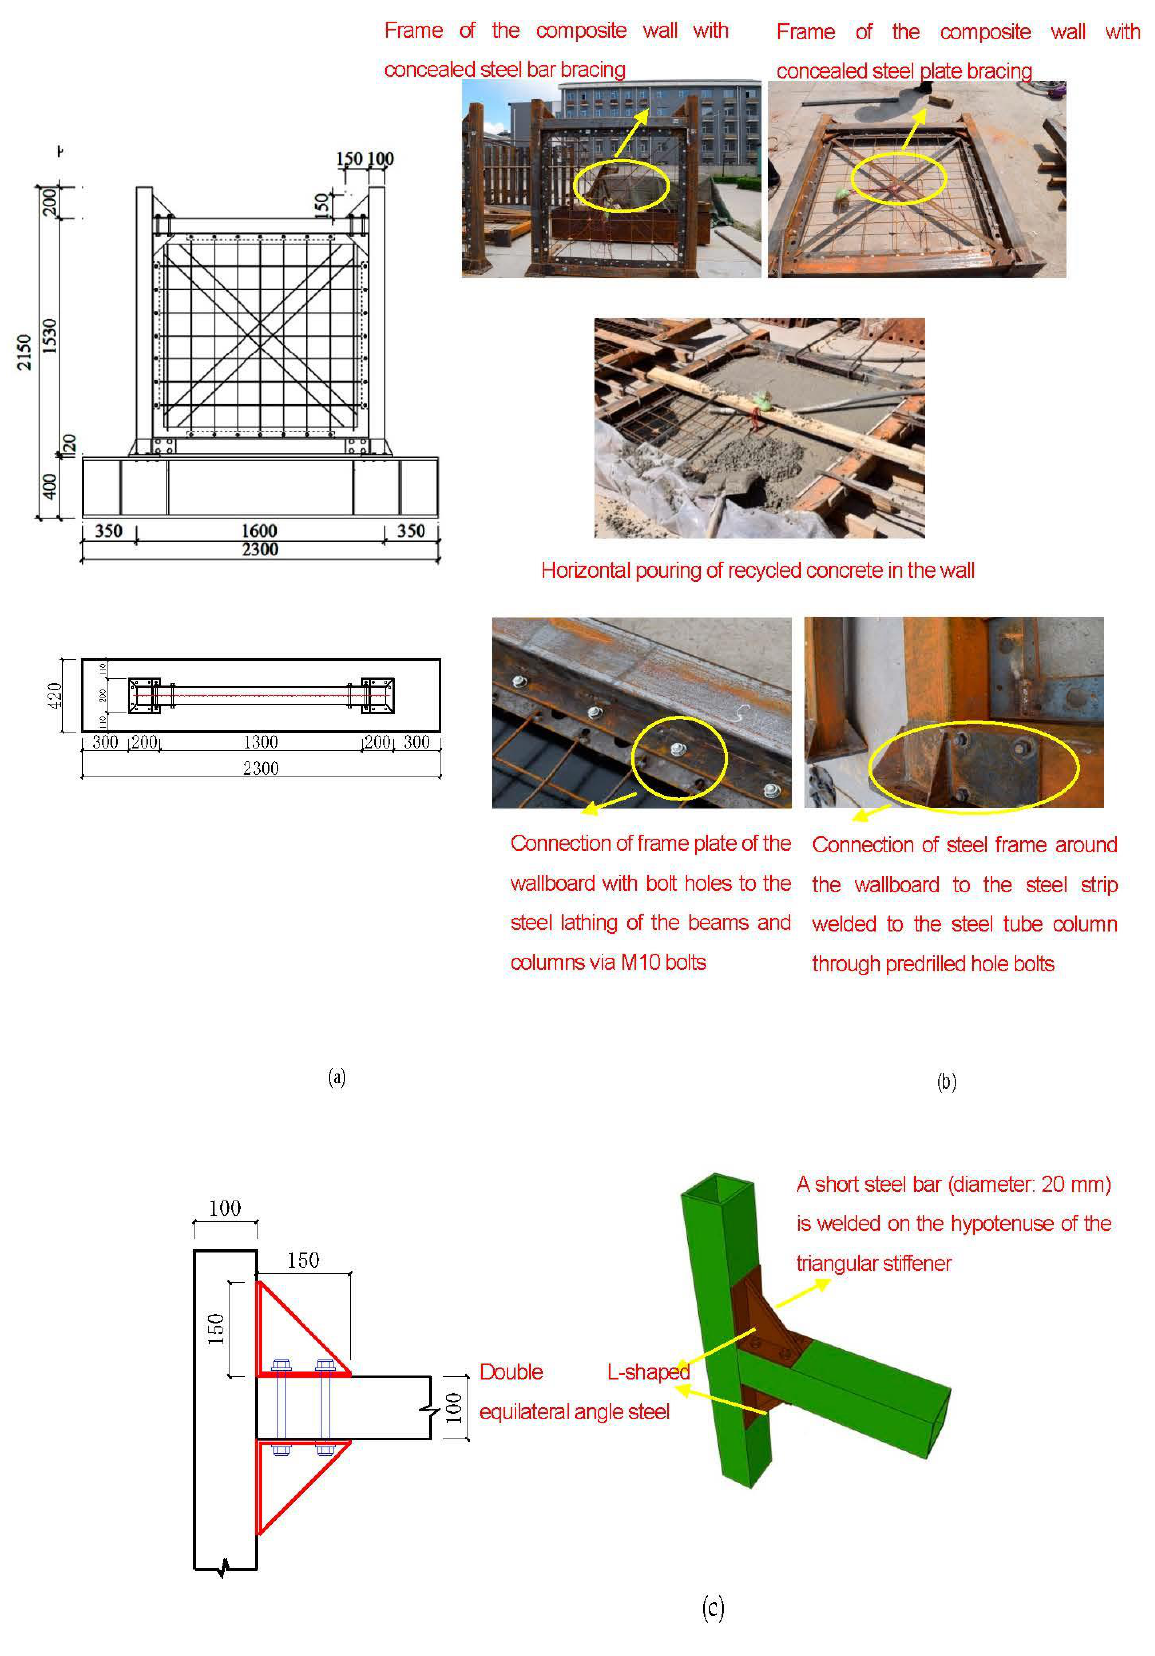
Figure 2. Dimensions and detailed structural diagram of the test piece. ( a ) Geometric dimensions of the specimen, ( b ) diagrammatical sketch of pre-fabrication, and ( c ) beam-column joint.